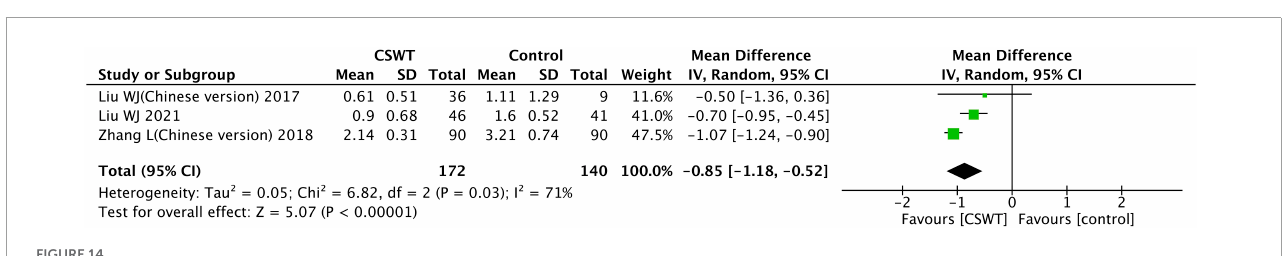
FIGURE14 Forest plot of the CSWT group vs. the control group-nitrate consumption